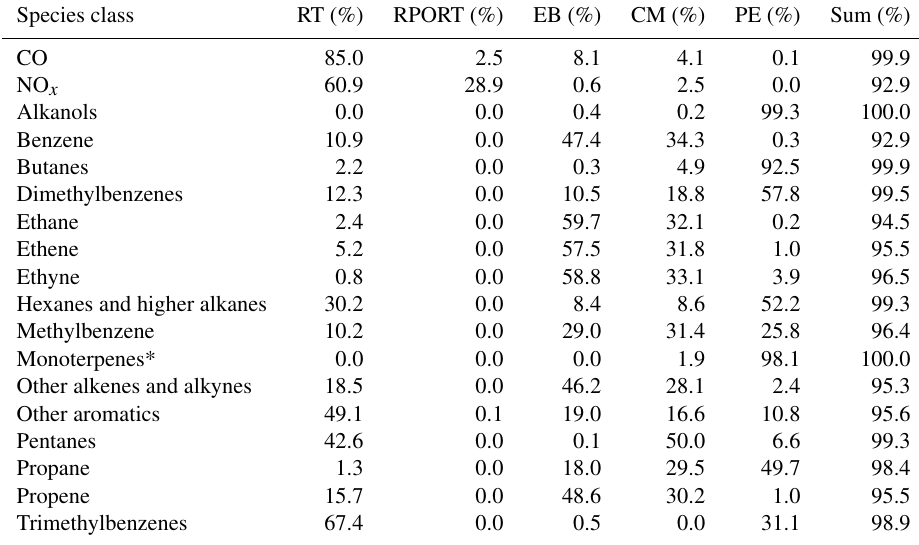
Table 2. Relative proportion of pollutants emitted from five EDGAR emission inventory source sectors: road transport (RT); railways, pipelines, and off-road transport (RPORT); energy for buildings (EB); combustion for manufacturing (CM); and process emissions (PE). Species class